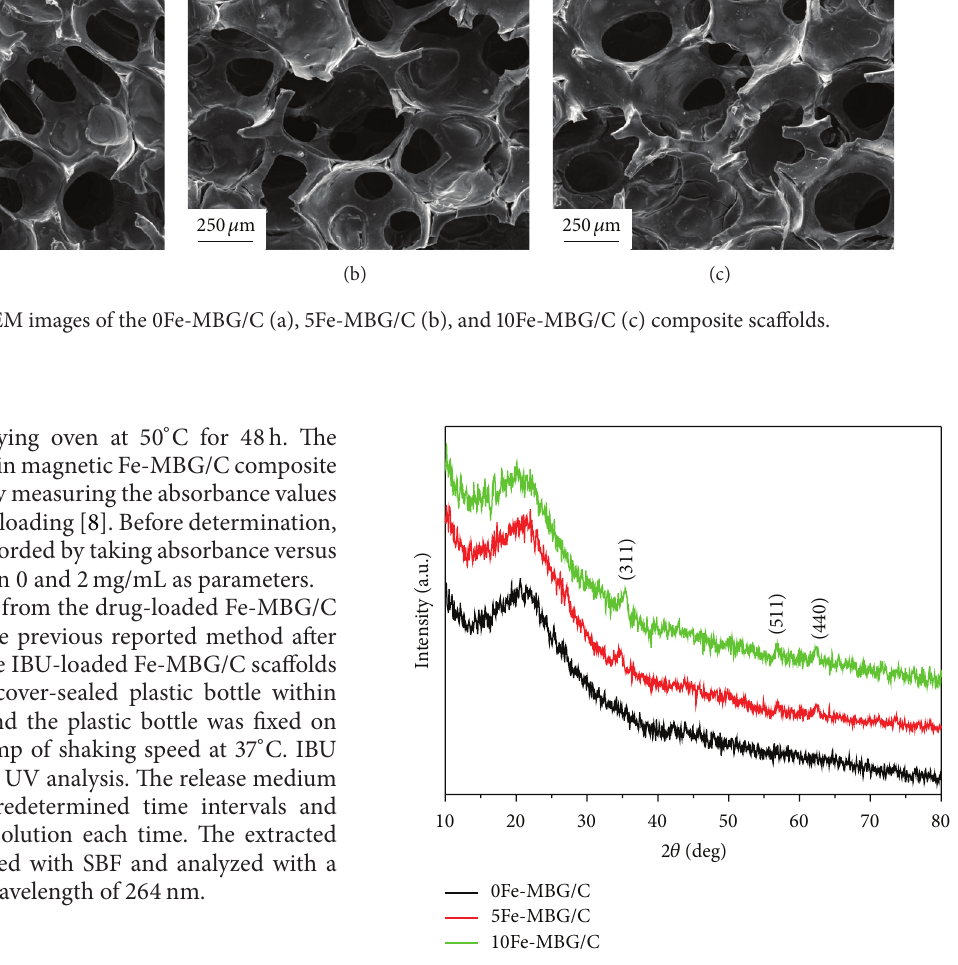
Figure 3: The WAXRD patterns of the Fe-MBG/C composite scaffolds with different Fe